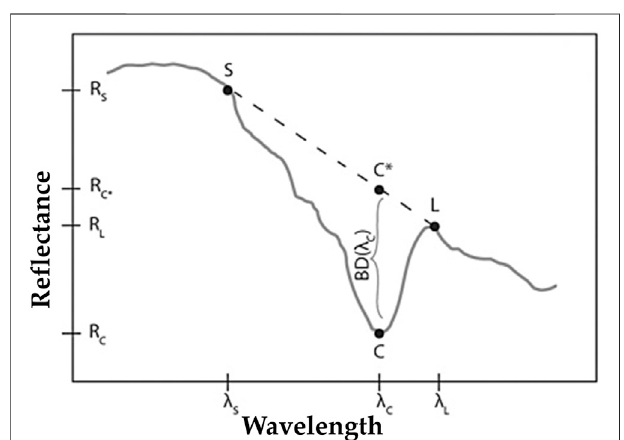
FIGURE5| ƛ c, λ s,and λ Lderivedtocalculateaandbparameterusedin CRISM browse product formulations: ƛ c is the re fl ectance at the center wavelength, λ s is the re fl ectance value at shorter wavelength, and λ L is longer wavelength points along the continuum as shown in fi gure (Clark and Roush,